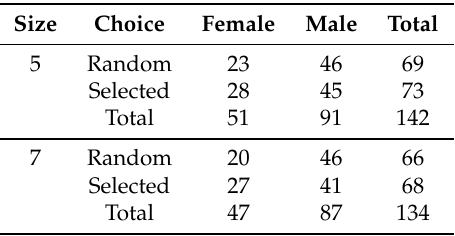
Table 2. Frequency table for studied factors.